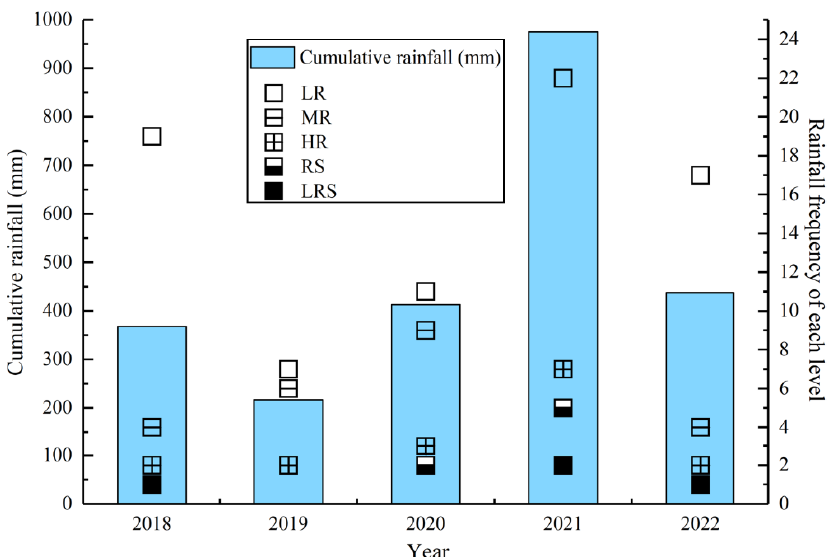
Figure 1. Distribution of cumulative rainfall and frequency.